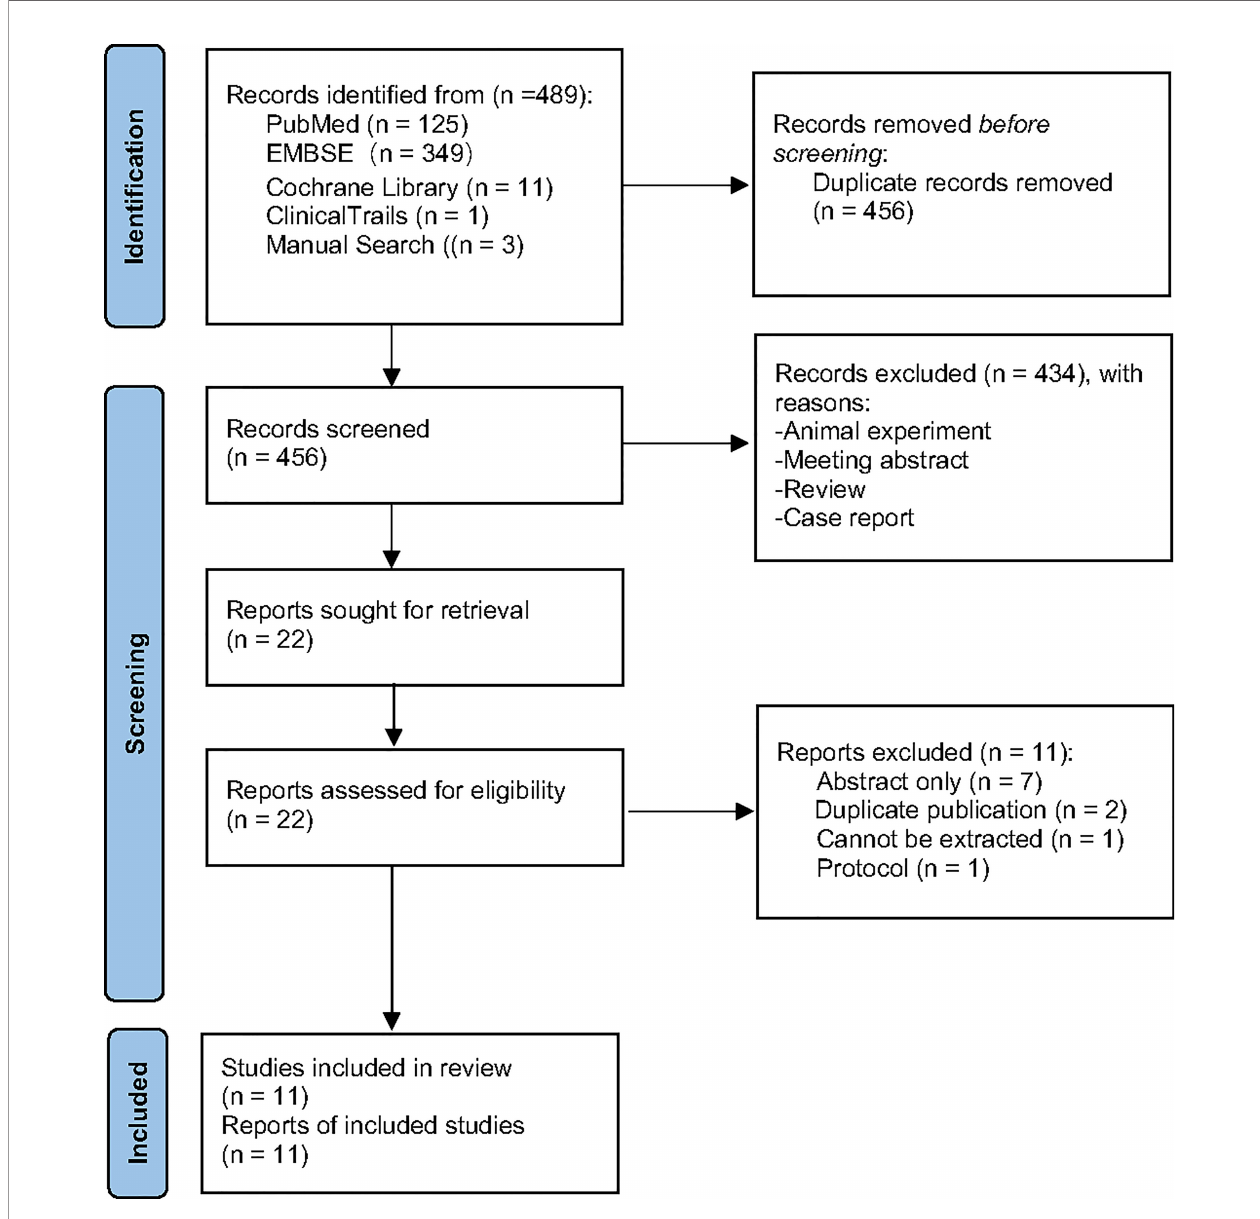
FIGURE 1 | PRISMA 2020 fl ow